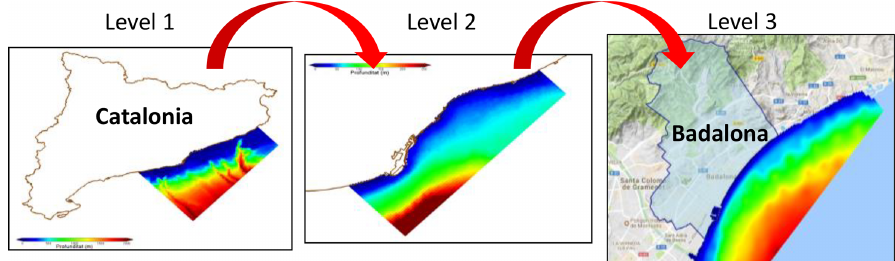
Figure 5. The three model domains of the seawater quality model. The colors represent the bathymetry (blue represents shallow and red represents deep). Background image from © Google Maps.